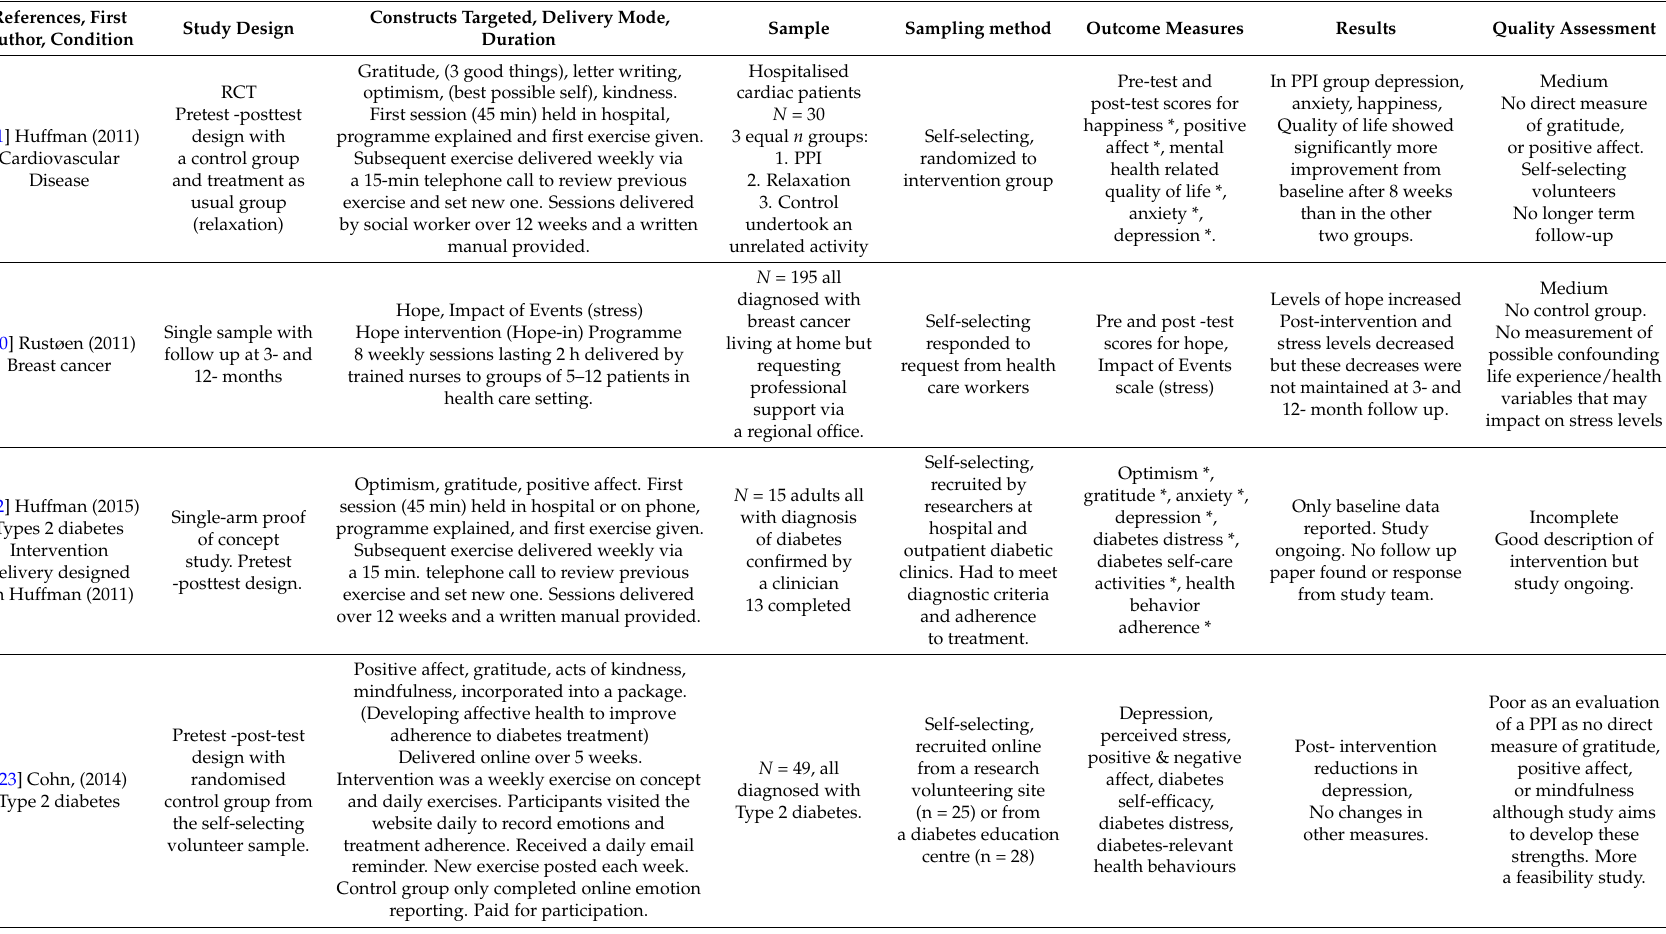
Table 1. Characteristics of included